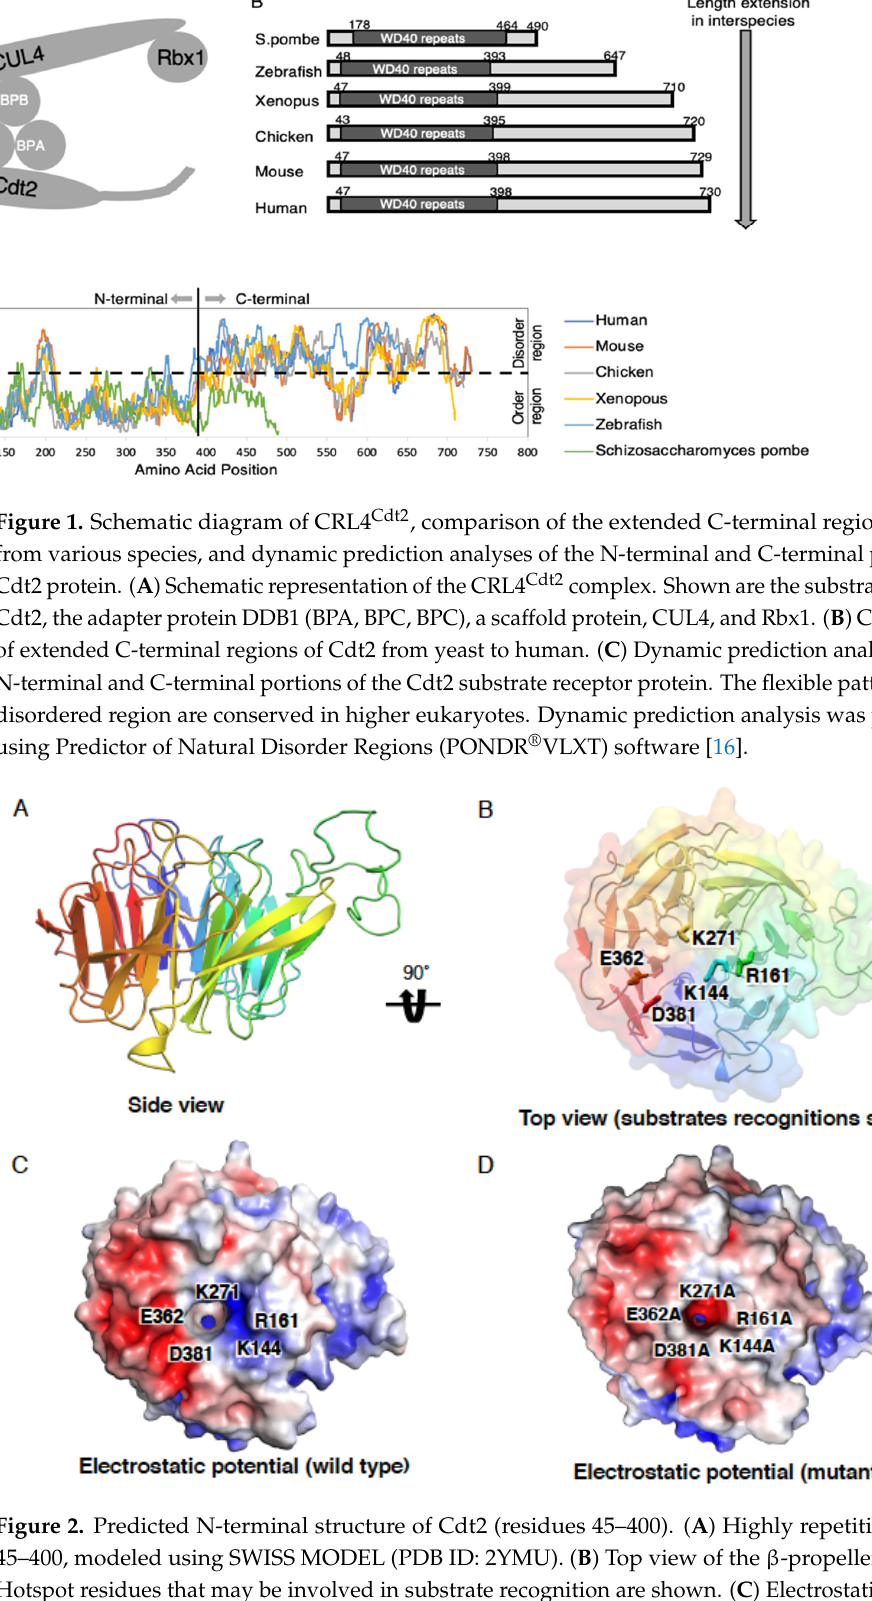
Figure 1. Schematic diagram of CRL4 Cdt2 , comparison of the extended C-terminal regions of Cdt2 from various species, and dynamic prediction analyses of the N-terminal and C-terminal portions of Cdt2 protein. ( A ) Schematic representation of the CRL4 Cdt2 complex. Shown are the substrate re- ceptor Cdt2, the adapter protein DDB1 (BPA, BPC, BPC), a scaffold protein, CUL4, and Rbx1. ( B ) Comparison of extended C-terminal regions of Cdt2 from yeast to human. ( C ) Dynamic prediction analyses of the N-terminal and C-terminal portions of the Cdt2 substrate receptor protein. The flex- ible patterns in the disordered region are conserved in higher eukaryotes. Dynamic prediction anal-